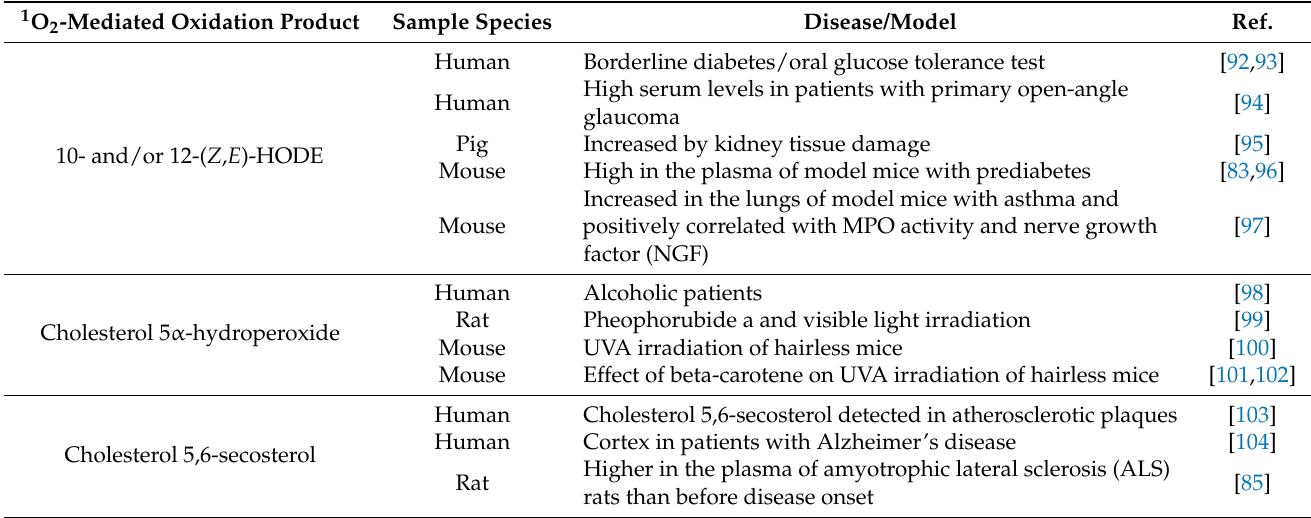
Table 2. Report on the results of the determination of linoleic acid- or cholesterol-derived peroxides produced by 1 O 2 -mediated oxidation reactions using human and animal